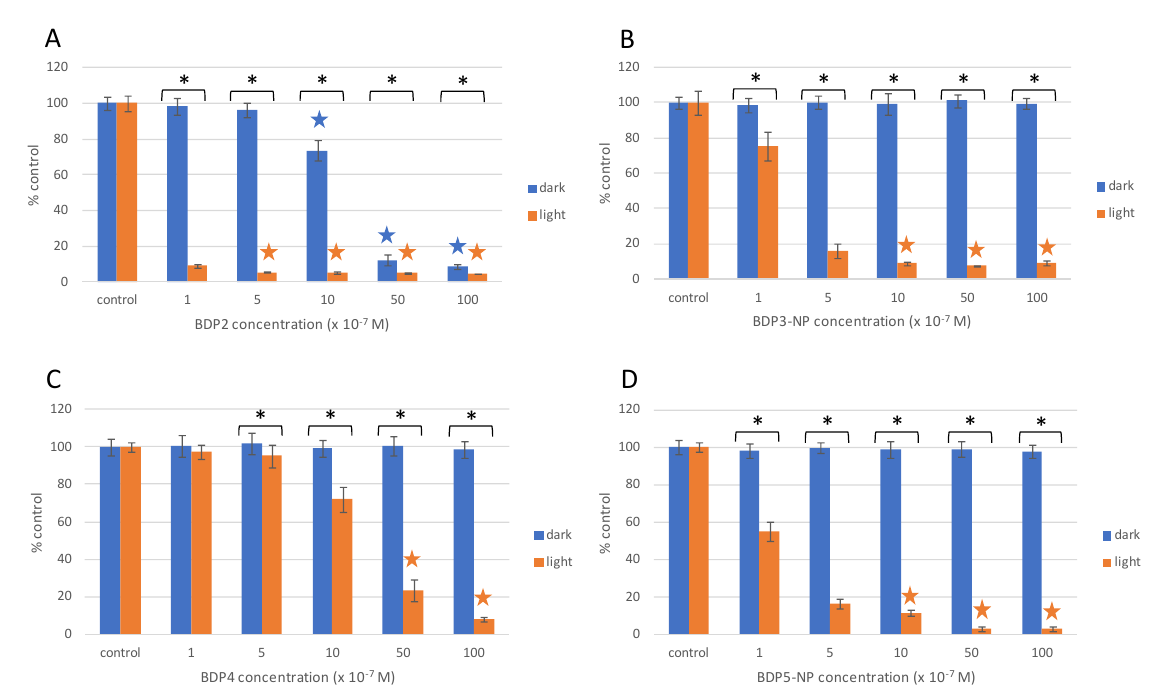
Figure 7. Cell viability (MTT assay) of HeLa cells exposed to the PSs in solution BDP2 ( A ) and BDP4 ( C ) and to their corresponding nanosystems BDP3-NP ( B ) and BDP5-NP ( D ) under dark conditions (blue bars) and after green irradiation at 10 J/cm 2 (orange bars). Stars indicate significant differences with respect to controls. Asterisks indicate significant differences between dark and light conditions at the same concentrations tested.